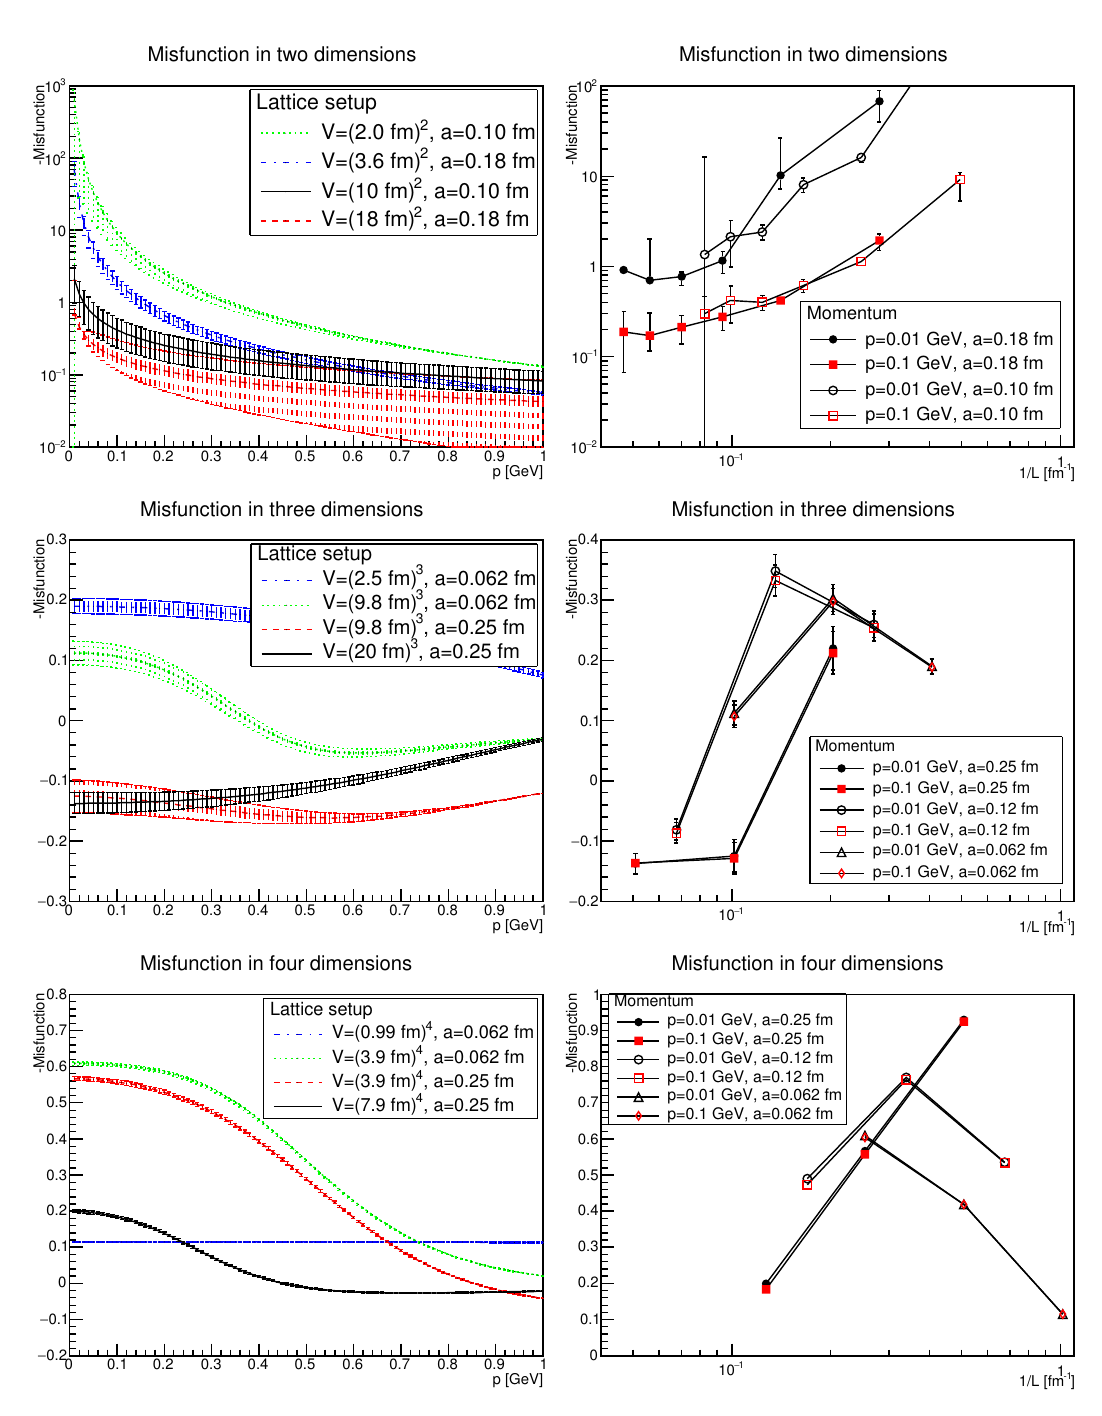
Figure 4: The misfunction (left panel) and its value at fixed momentum as a function of volume (right panel) in two dimensions (top panels), three dimensions (middle panels), and four dimensions (bottom